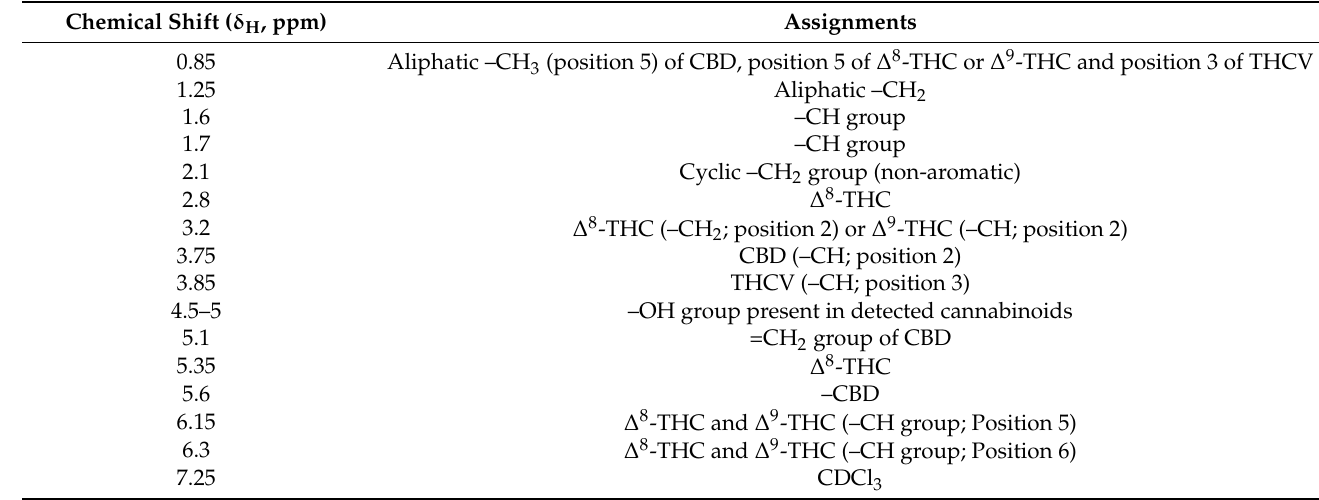
Table 7. Peak assignments for 1 H NMR spectrum of cannabis oil obtained from SCCO 2 extraction.